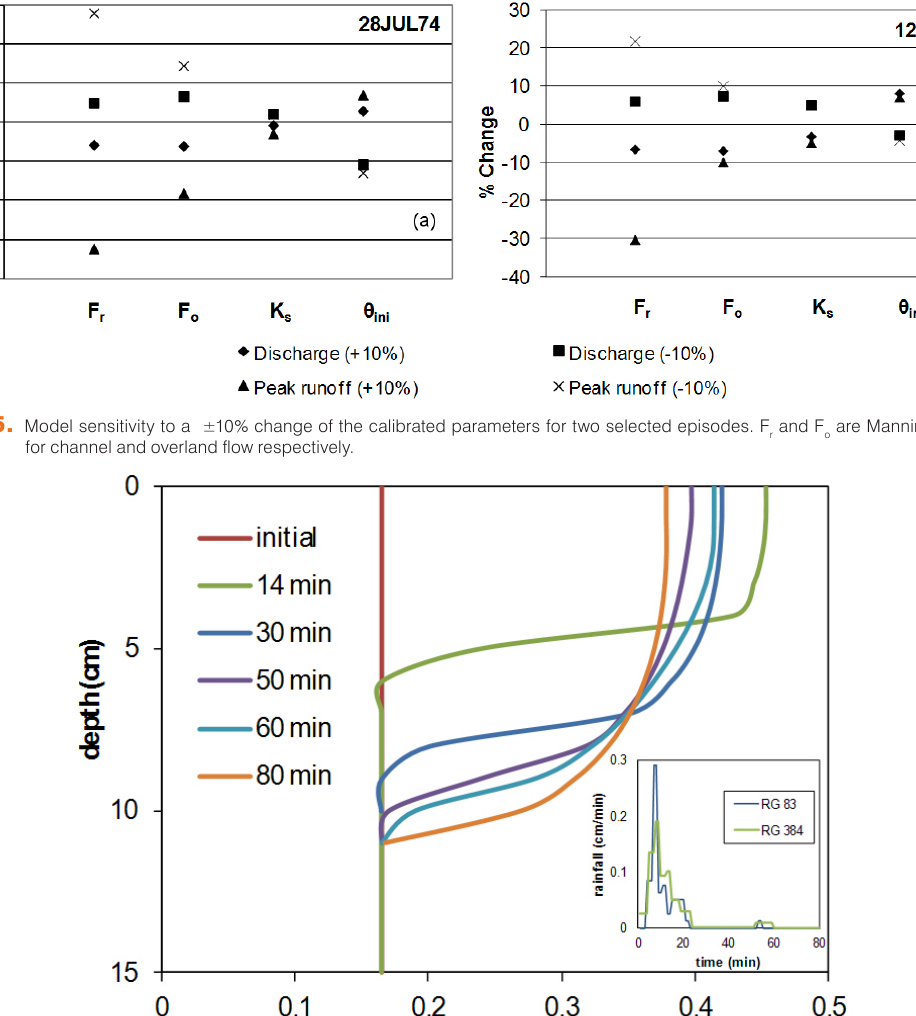
Figure 6. Application of the subsurface flow component: soil moisture content Θ profile for unit mu=4 of overland cascade ncascd=2 of reach JR=4 of river IR=1 for the storm episode of 28 th July 1974 for a time period of 80 minutes. The embedded figure is the illustration of the two rain gauges (RG 83 and RG 384)